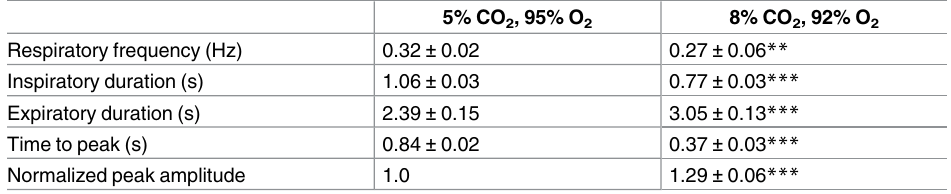
Table 2. Comparison of variables of PN activity during normocapnia (5% CO 2 ) and hypercapnia (8% CO 2 ) ( n = 21).